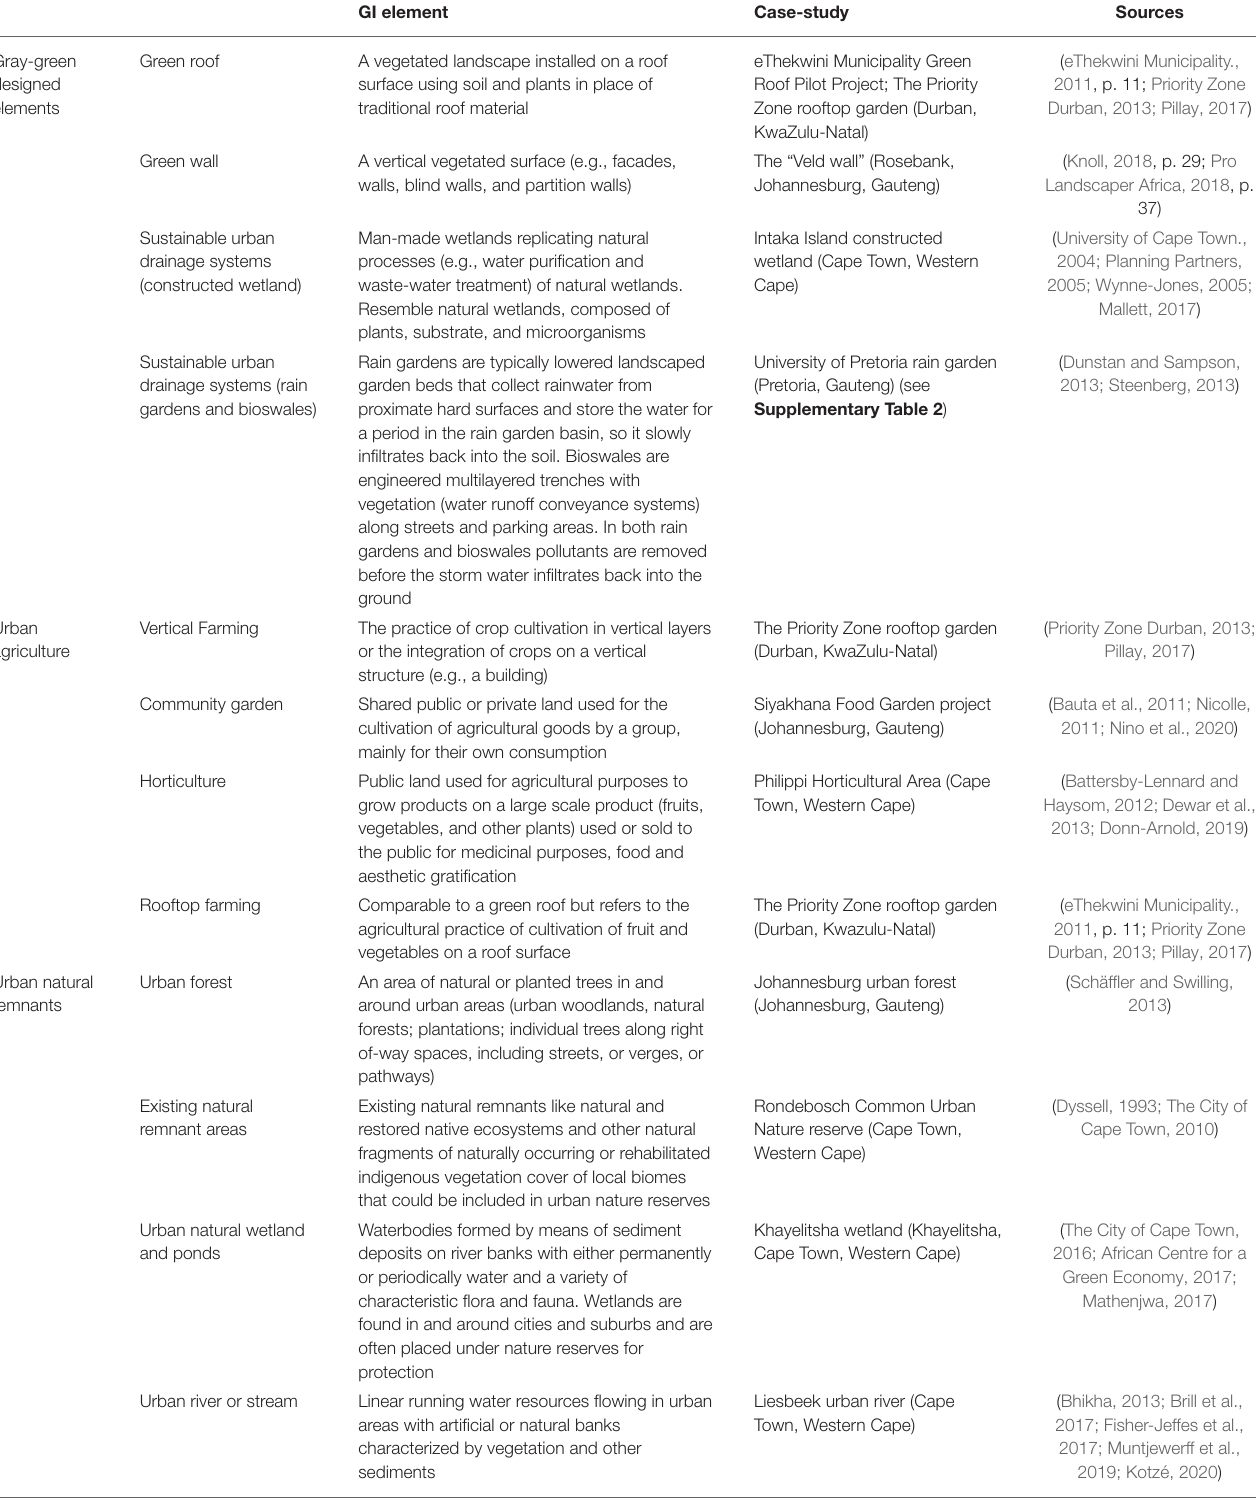
TABLE 1 | A GI typology inventory and selected case studies with examples of specific GI elements. GI